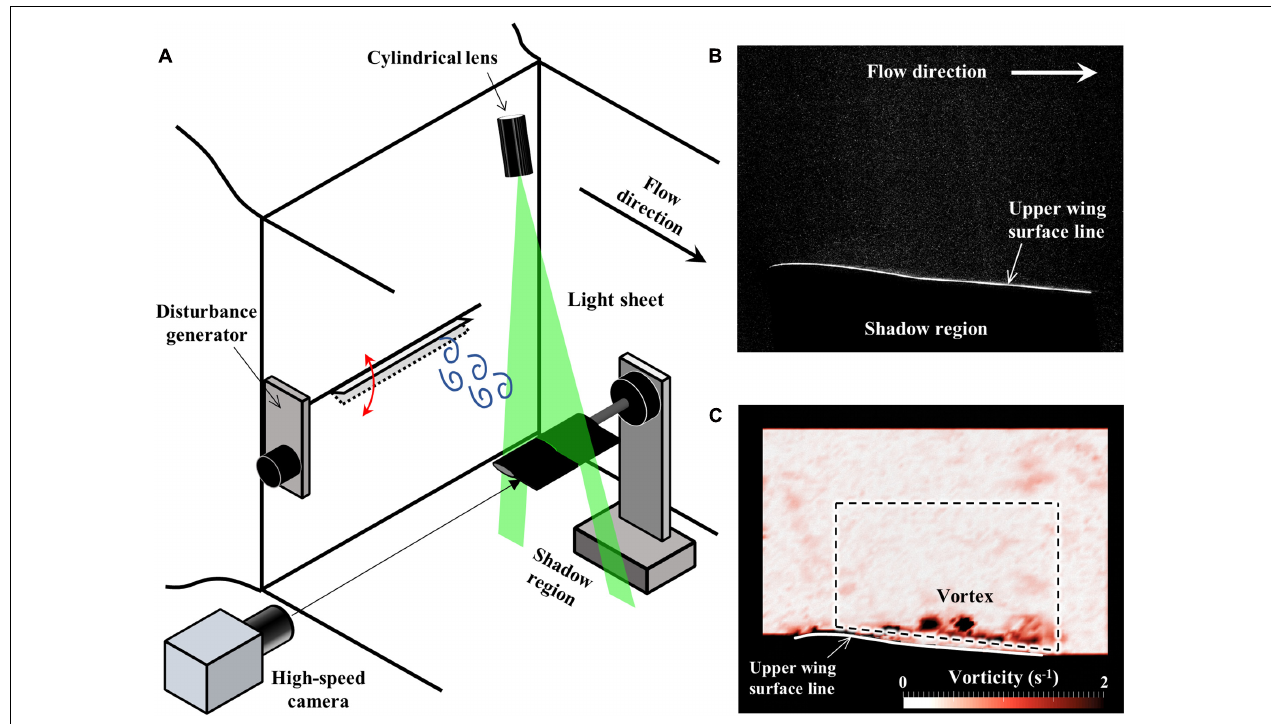
FIGURE 3 | (A) Schematic diagram of the experimental setup for 2D-PIV measurements. (B) A raw image of PIV measurements. Since the laser light was irradiated from above of the wing, the area lower than the wing was in the shadows and too dark to see the particles. (C) The sample flow field is visualized by the distribution of the vorticity. The surrounding area in black was masked during the analysis of the PIV due to the low light level. The area inside the dashed line was defined to calculate the ratio of high vorticity